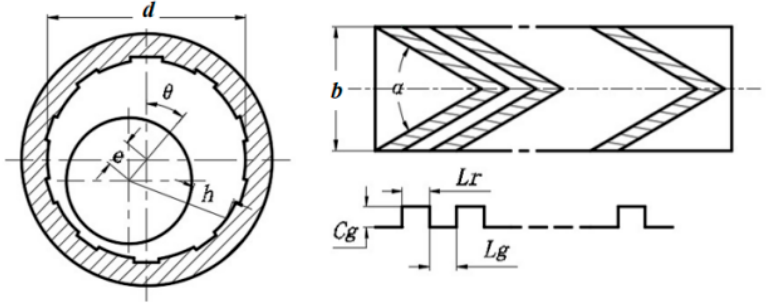
Figure 2. The structural diagram of V-g B.